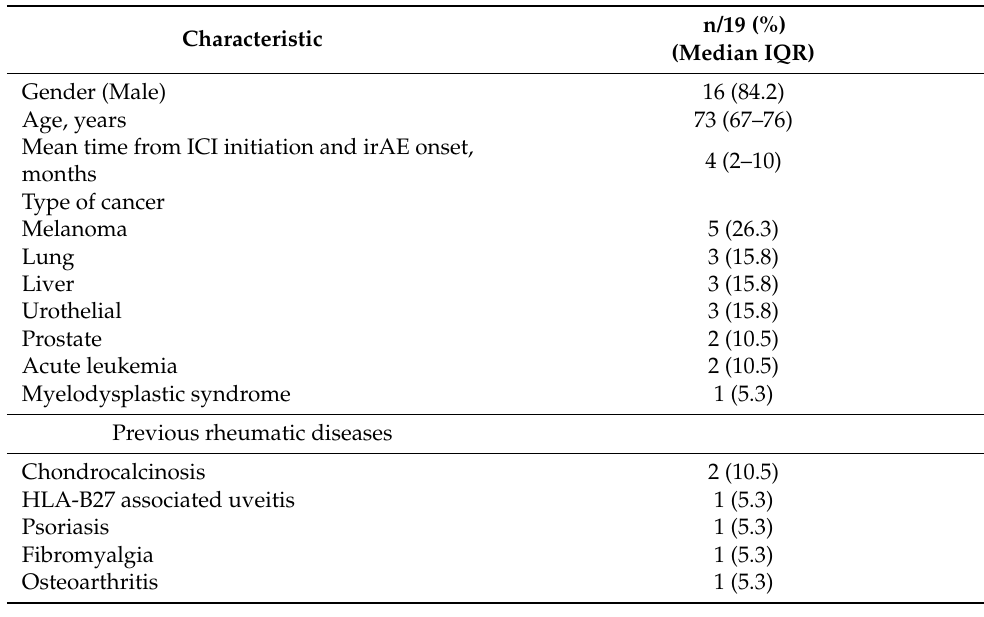
Table 1. General characteristics, type of cancer and ICI